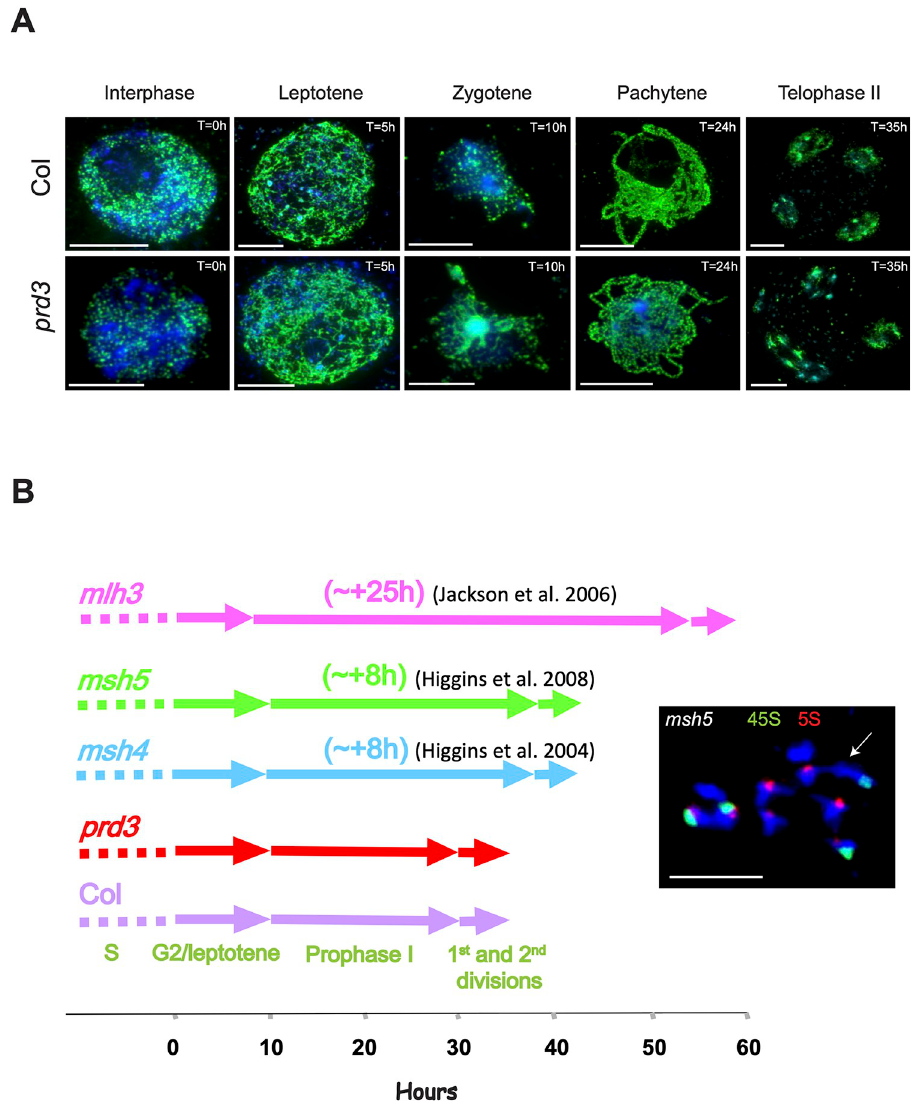
Fig 7. Meiotic duration in wild type and prd3 measured using BrdU incorporation. ( A ) Staining of BrdU (green) and chromatin (DAPI, blue) at defined pre-meiotic and meiotic stages following a BrdU pulse in wild type (Col) and prd3 . Scale bar = 10 μ M. ( B ) Schematic representation showing the duration of meiosis in wild type (Col), prd3 , msh4 [63], msh5 [64] and mlh3 [65]. Metaphase I labelled with 45s (green) and 5s (red) rDNA FISH probes. White arrow shows a chiasma between non-homologous chromosomes in msh5 . Chromatin is stained in blue. Scale bar = 10 μ